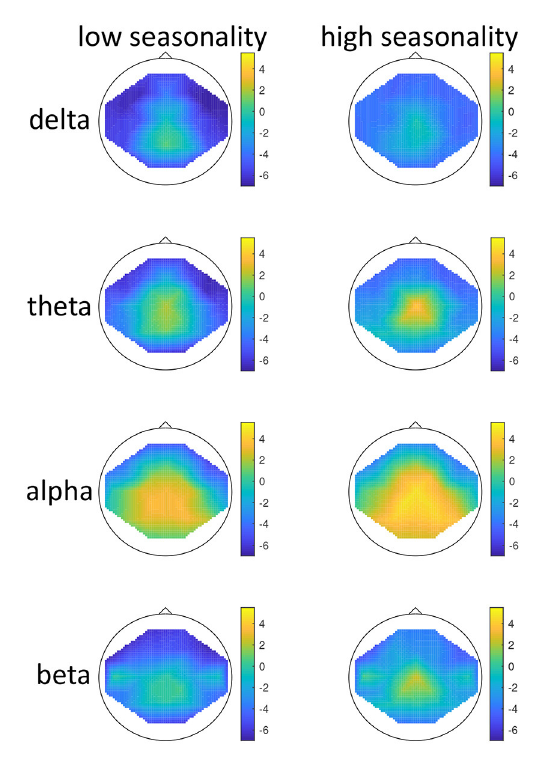
FIGURE3 Topographical maps of activity distribution: Colors represent difference between rest and after mood induction, indicated by approximated z -values from a Wilcoxon signed rank test, for frequency ranges from top to bottom : delta, theta, alpha, beta; and for groups with low (left) and high (right) global seasonality score. Negative z -values indicate lower activity during rest compared to mood induction, positive z -values indicate higher activity during rest compared to mood